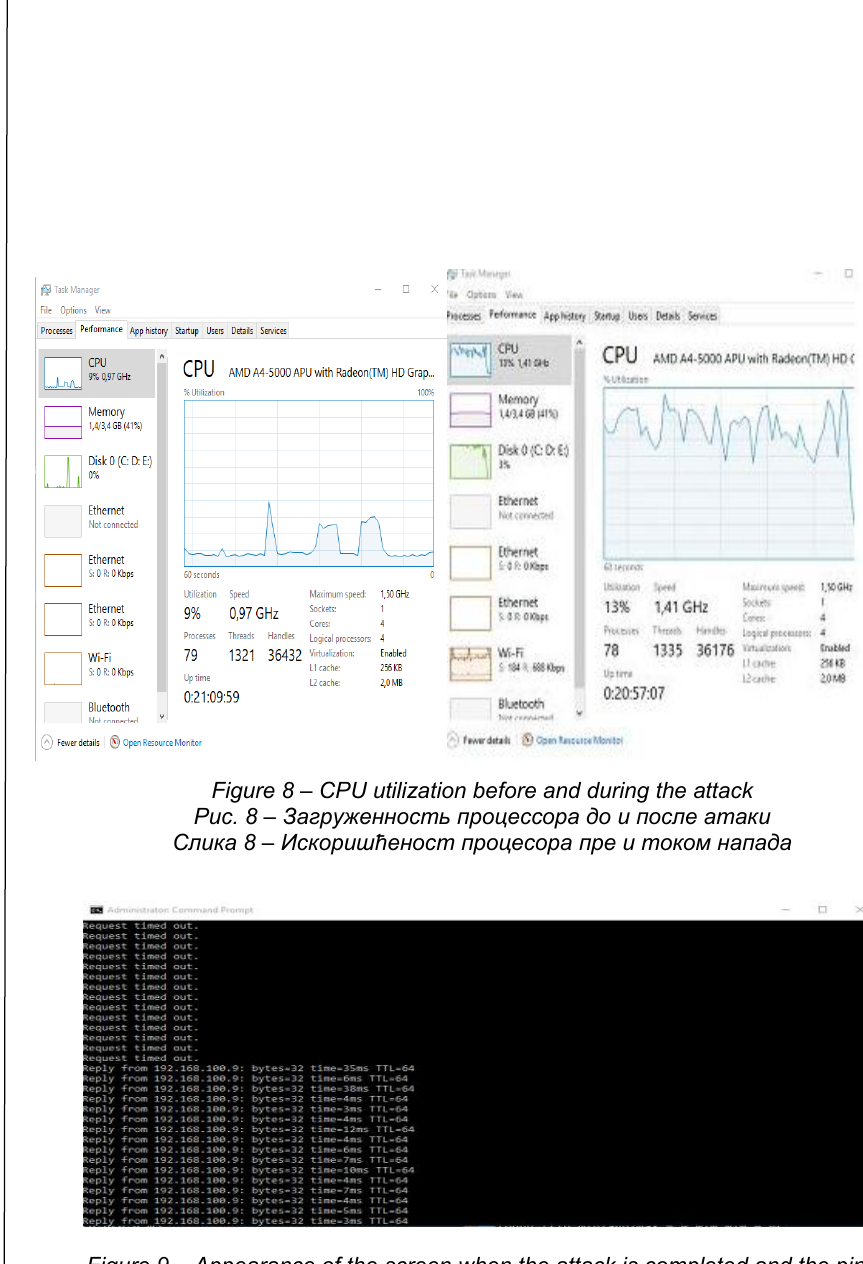
Figure 9 – Appearance of the screen when the attack is completed and the ping command is